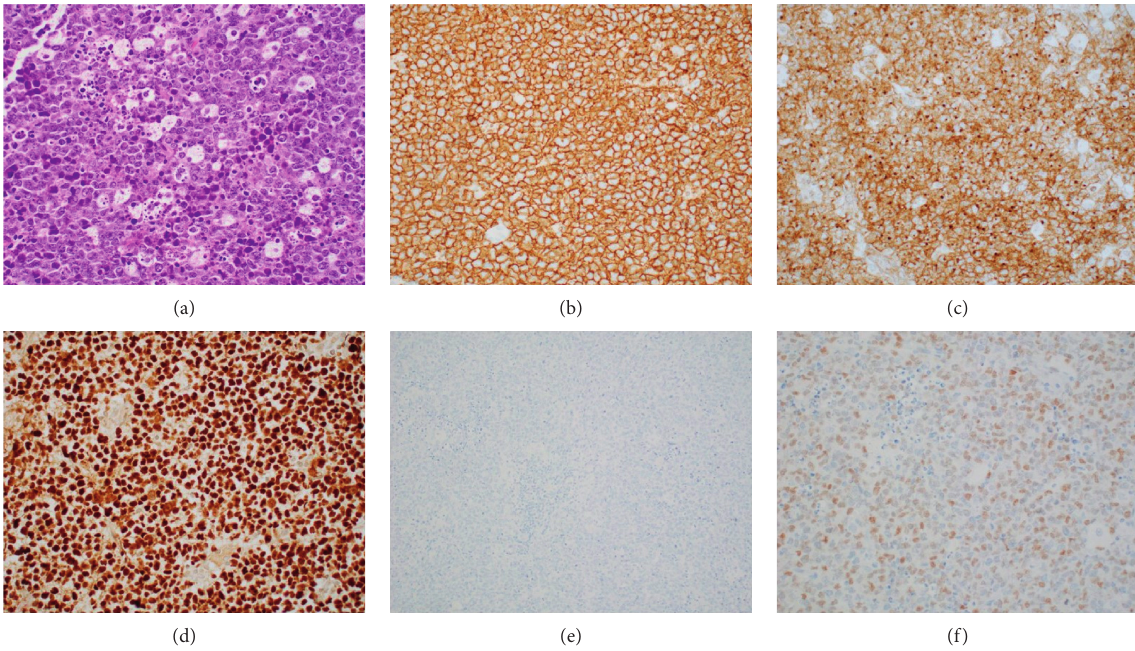
Figure 1: Neck mass in a 17-year-old female. (a) Sections show a diffuse proliferation of intermediate-sized atypical cells with prominent nucleoli in a background of apoptotic debris and numerous tingible-body macrophages (hematoxylin-eosin, original magnification 40x). The tumor cells are positive for (b) CD20 (original magnification 40x), (c) CD10 (original magnification 40x), and (d) BCL-6 (original magnification 40x) and negative for (e) CD56 (original magnification 20x). The tumor cells show weak MYC expression (f) (original magnification